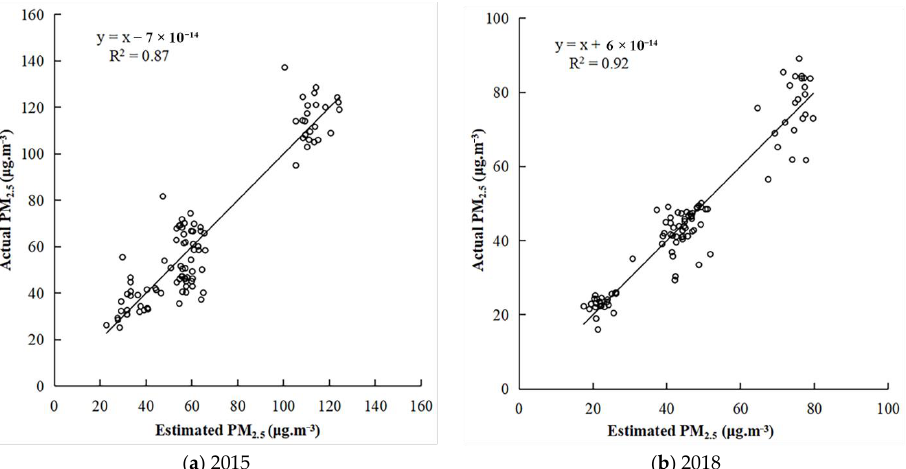
Figure 3. Scatter plots of estimated and actual PM 2.5 concentrations.